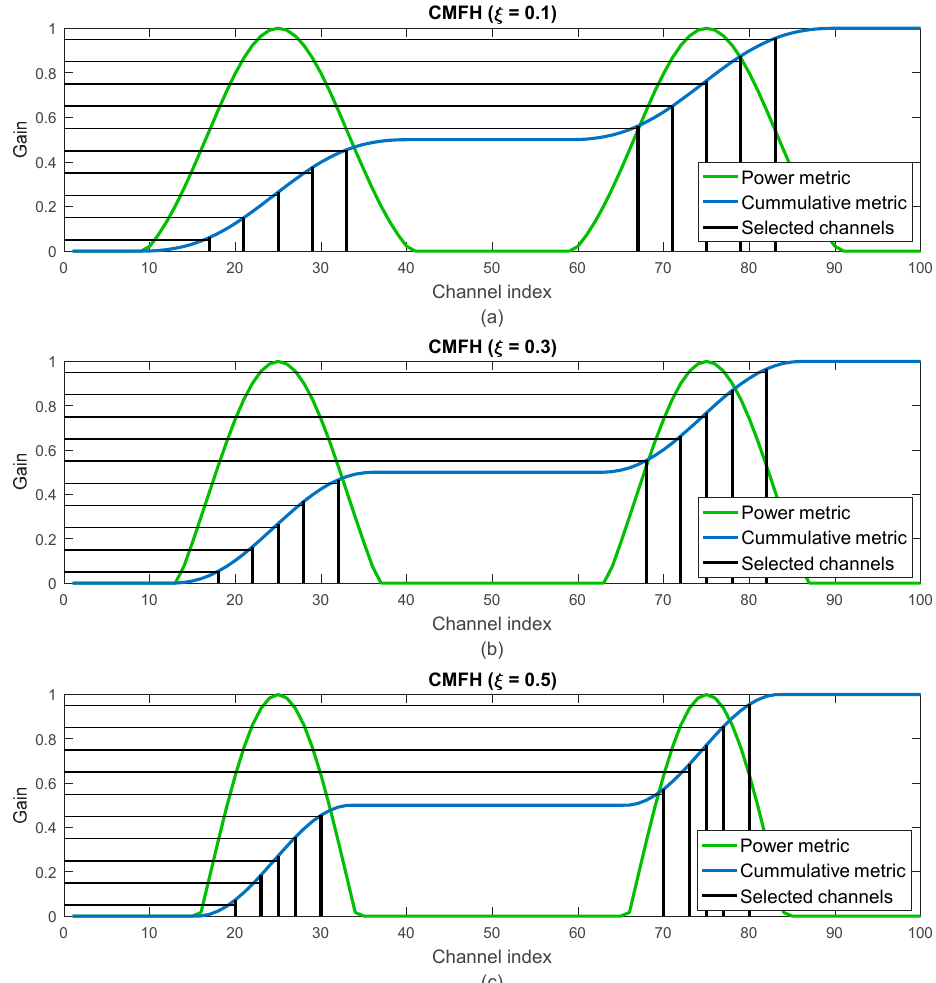
Figure 9. Channel selection evolution in the Clipped Matched Frequency Hopping (CMFH) technique when varying the threshold parameter: ( a ) (cid:2022) = 0.1 ; ( b ) (cid:2022) = 0.3 ; ( c ) (cid:2022) = 0.5 .